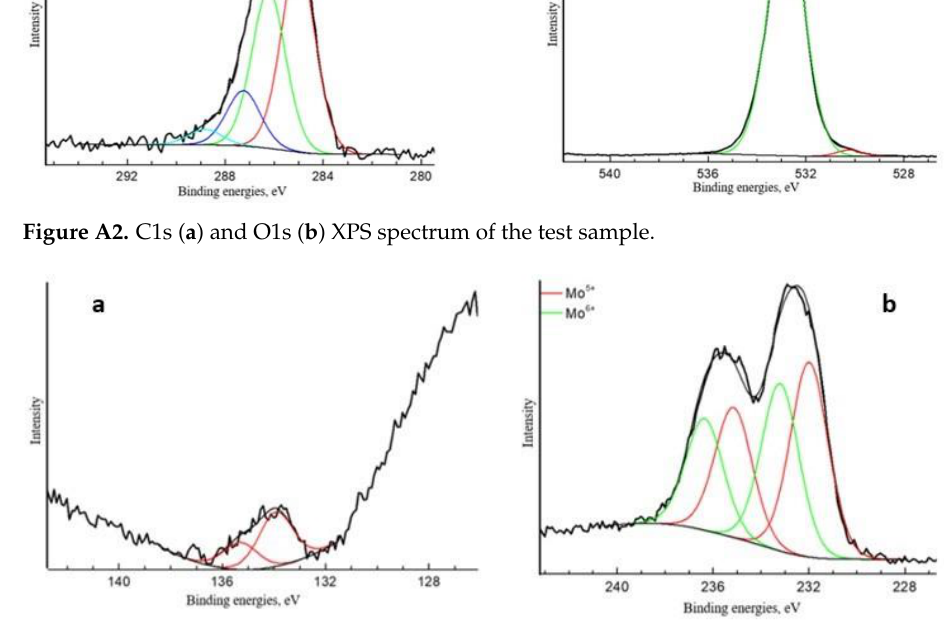
Figure A4. Mo3p/N1s ( a ) and S2p ( b ) XPS spectrum of the test sample.